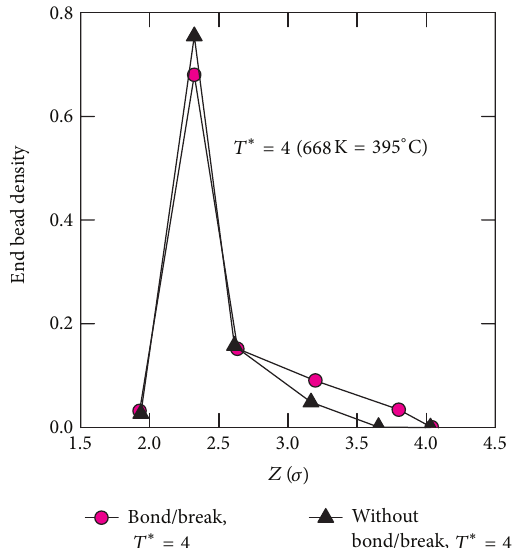
Figure 9: Effects of temperature on end bead density of PFPE Zdol lubricant molecules on a DLC substrate for the case of bond/break and without bond/break at temperature 𝑇 ∗ = 4 (668K = 395 ∘ C).